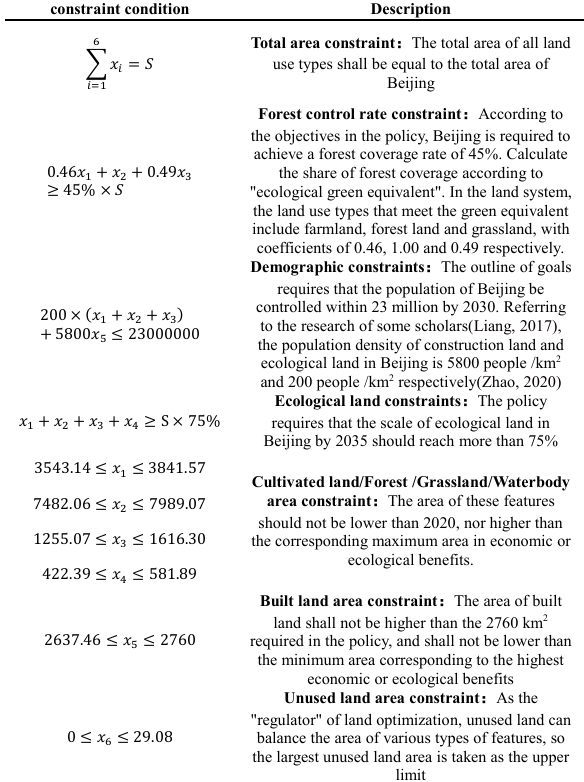
Table 2. Constraints on the objective function for the 2035 LC